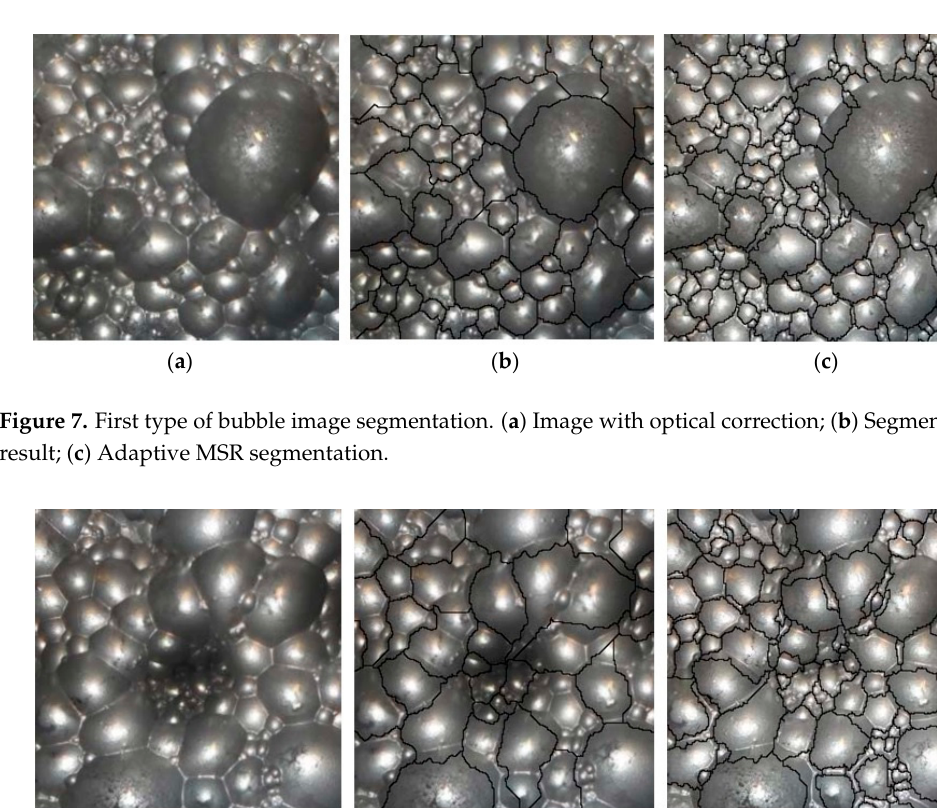
Figure 8. Second type of bubble image segmentation. ( a ) Image with optical correction; ( b ) Segmentation result; ( c ) Adaptive MSR segmentation.